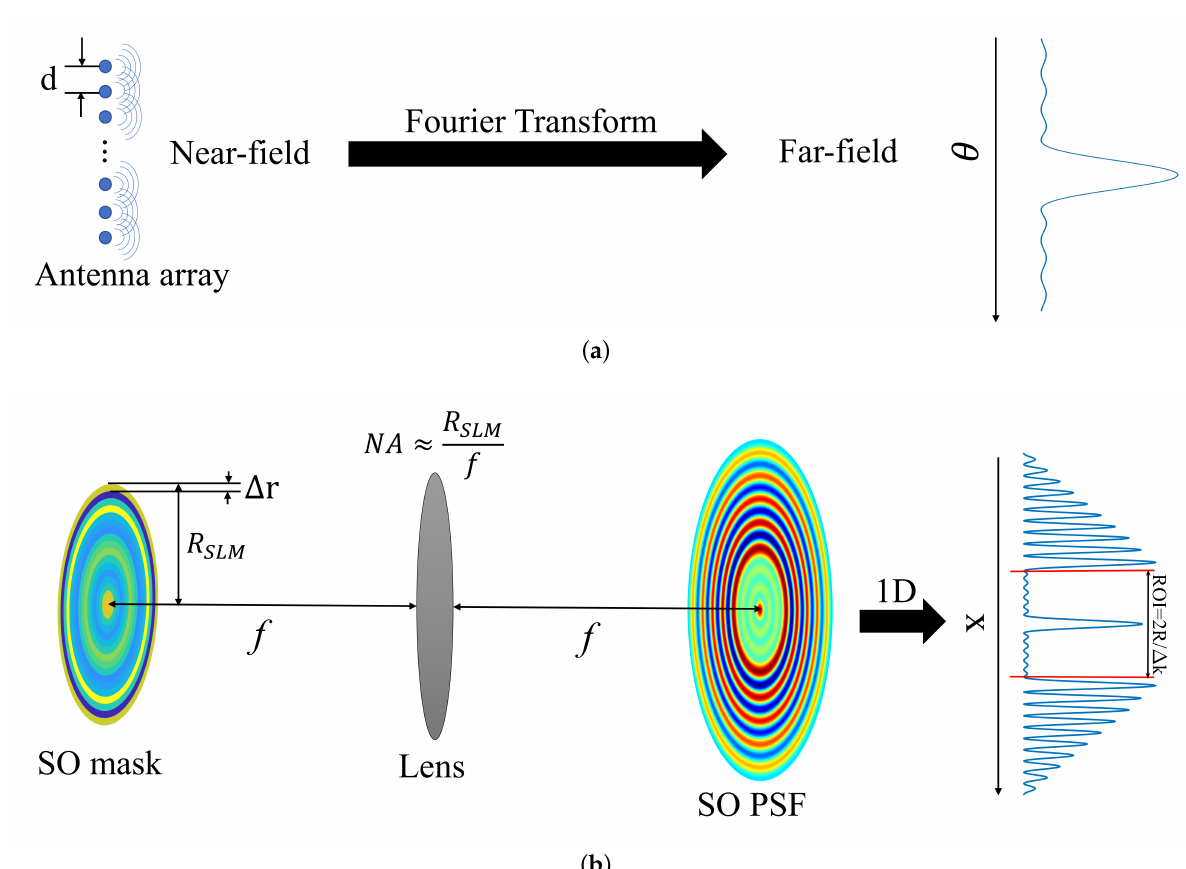
Figure 9. ( a ) Antenna array in the spatial domain and super-directivity in the angular domain. ( b ) SO mask in the frequency domain and super-oscillation in the spatial domain (SO denotes super-oscillatory and PSF denotes point-spred